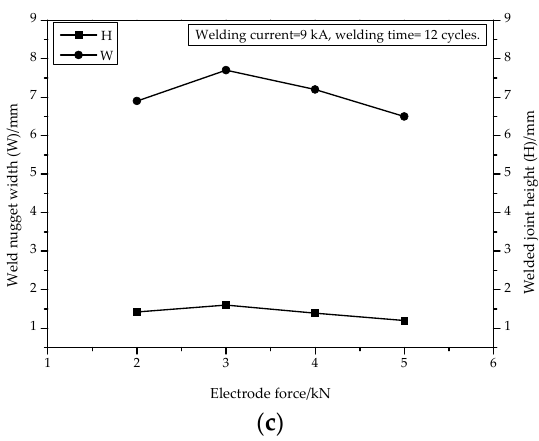
Figure 5. Effects of welding parameters on the spot weld morphology (W, H): ( a ) Welding current; ( b ) welding time; and ( c ) electrode force.